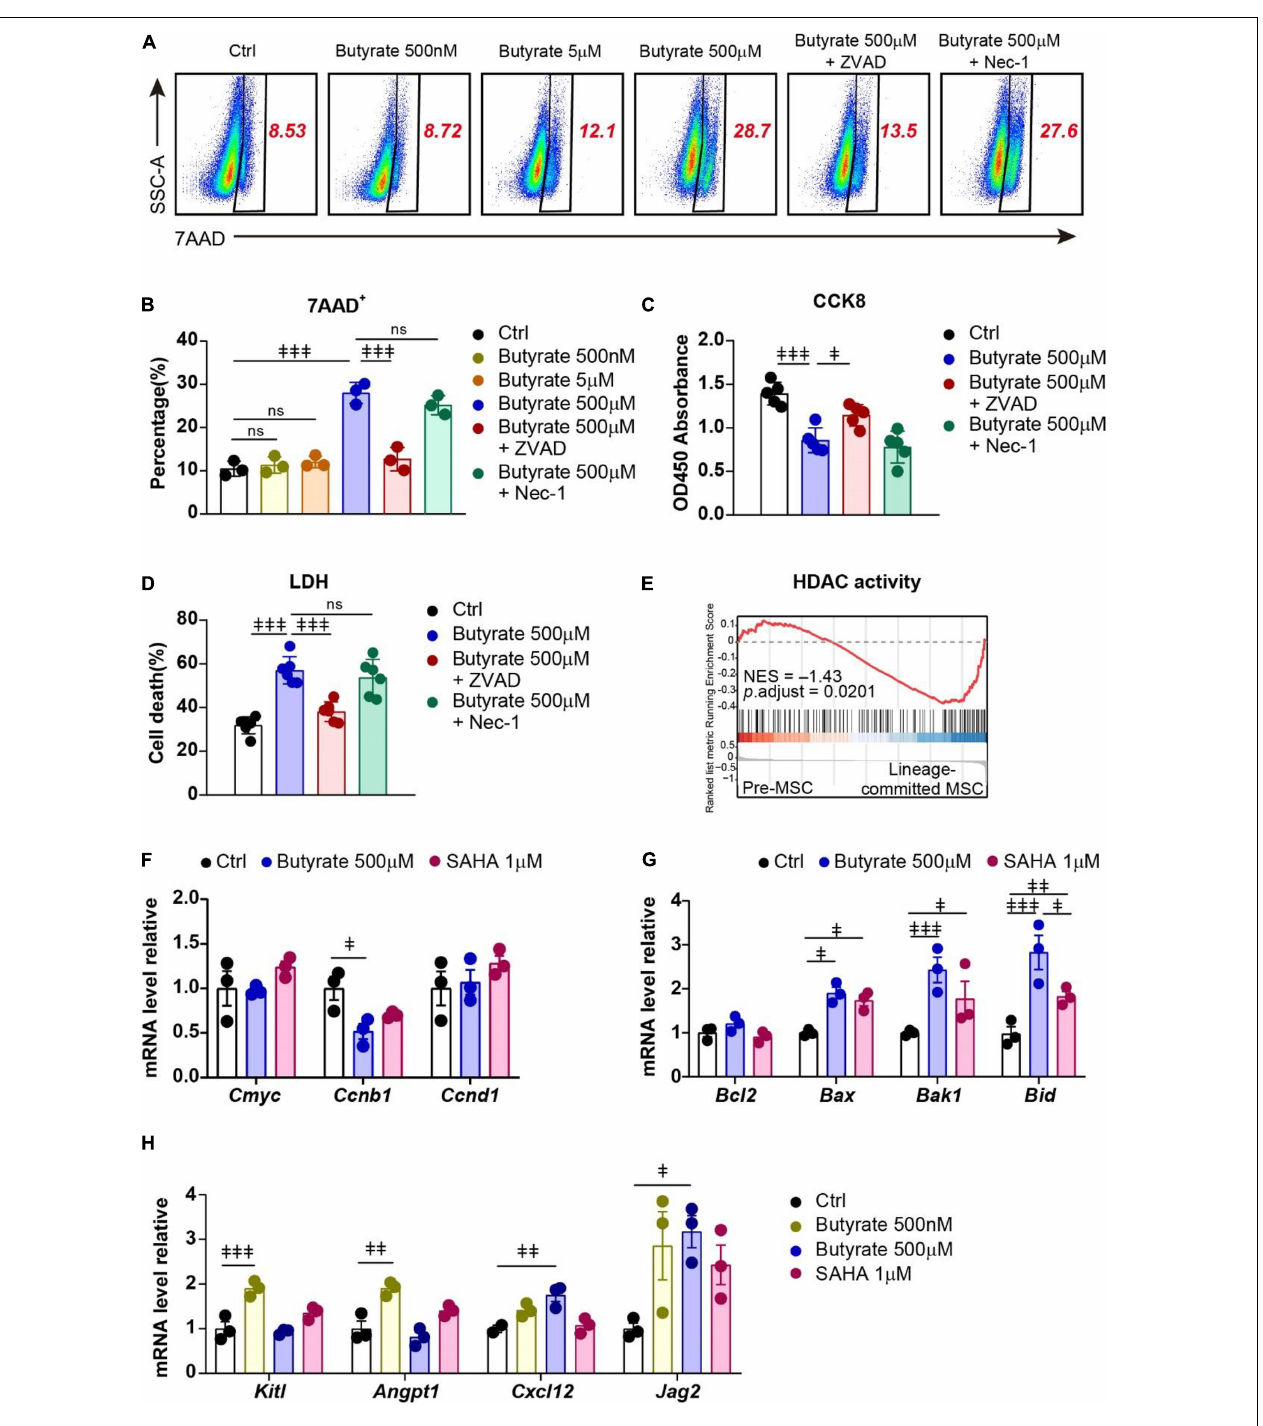
FIGURE 5 | Supplement of butyrate triggers apoptosis but promotes HSC niche factor expression in MSCs. (A) Representative flow cytometry plots of 7AAD staining of MSCs under different treatments as indicated. The numbers in the plots denote the percentage of gated cells. (B) Percentage of 7AAD + MSCs under different treatments as indicated. (C) CCK-8 assay showing MSC viability under different treatments as indicated. (D) LDH activity showing MSC death frequency under different treatments as indicated. (E) GSEA evaluating enrichment of genes associated with HDAC activity in pre- and lineage-committed MSCs. Normalized enrichment score and adjusted p value were calculated by permutation tests. (F) Quantitative RT-PCR of transcript levels of proliferation gene in MSCs with indicated treatments (normalized to control group). (G) Quantitative RT-PCR of transcript levels of apoptosis genes in MSCs with indicated treatments (normalized to control group). (H) Quantitative RT-PCR of transcript levels of HSC niche factor genes in MSCs with indicated treatments (normalized to control group). Repeated-measures one-way ANOVA followed by Dunnett’s test for multiple comparisons in (B–D,F–H) . ns, non-significant; p < 0.05, p < 0.01, p < 0.001.